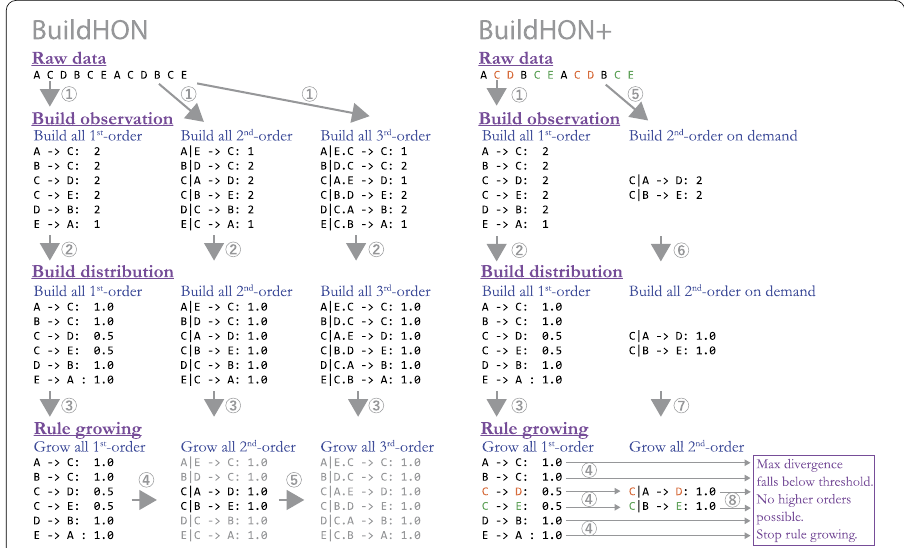
Figure 2 Comparison of the active observation construction in BuildHON (left) and the lazy observation construction in BuildHON+ (right, with a much smaller search space). Circled numbers represent the order of